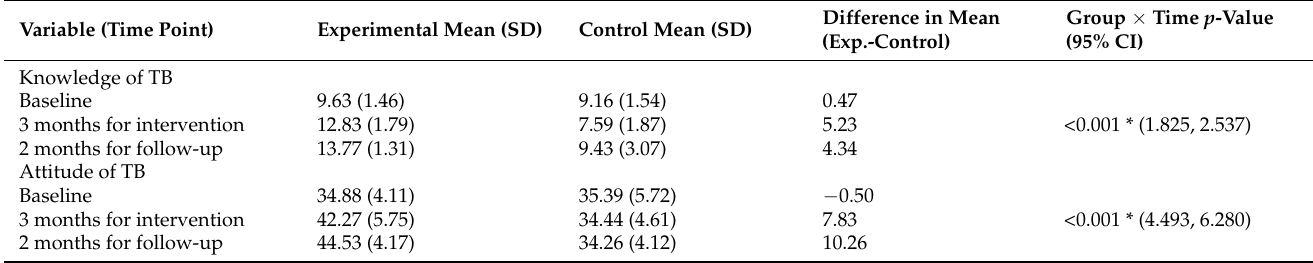
Table 4. Testing the effectiveness of the intervention on reduction in TB stigma and TB